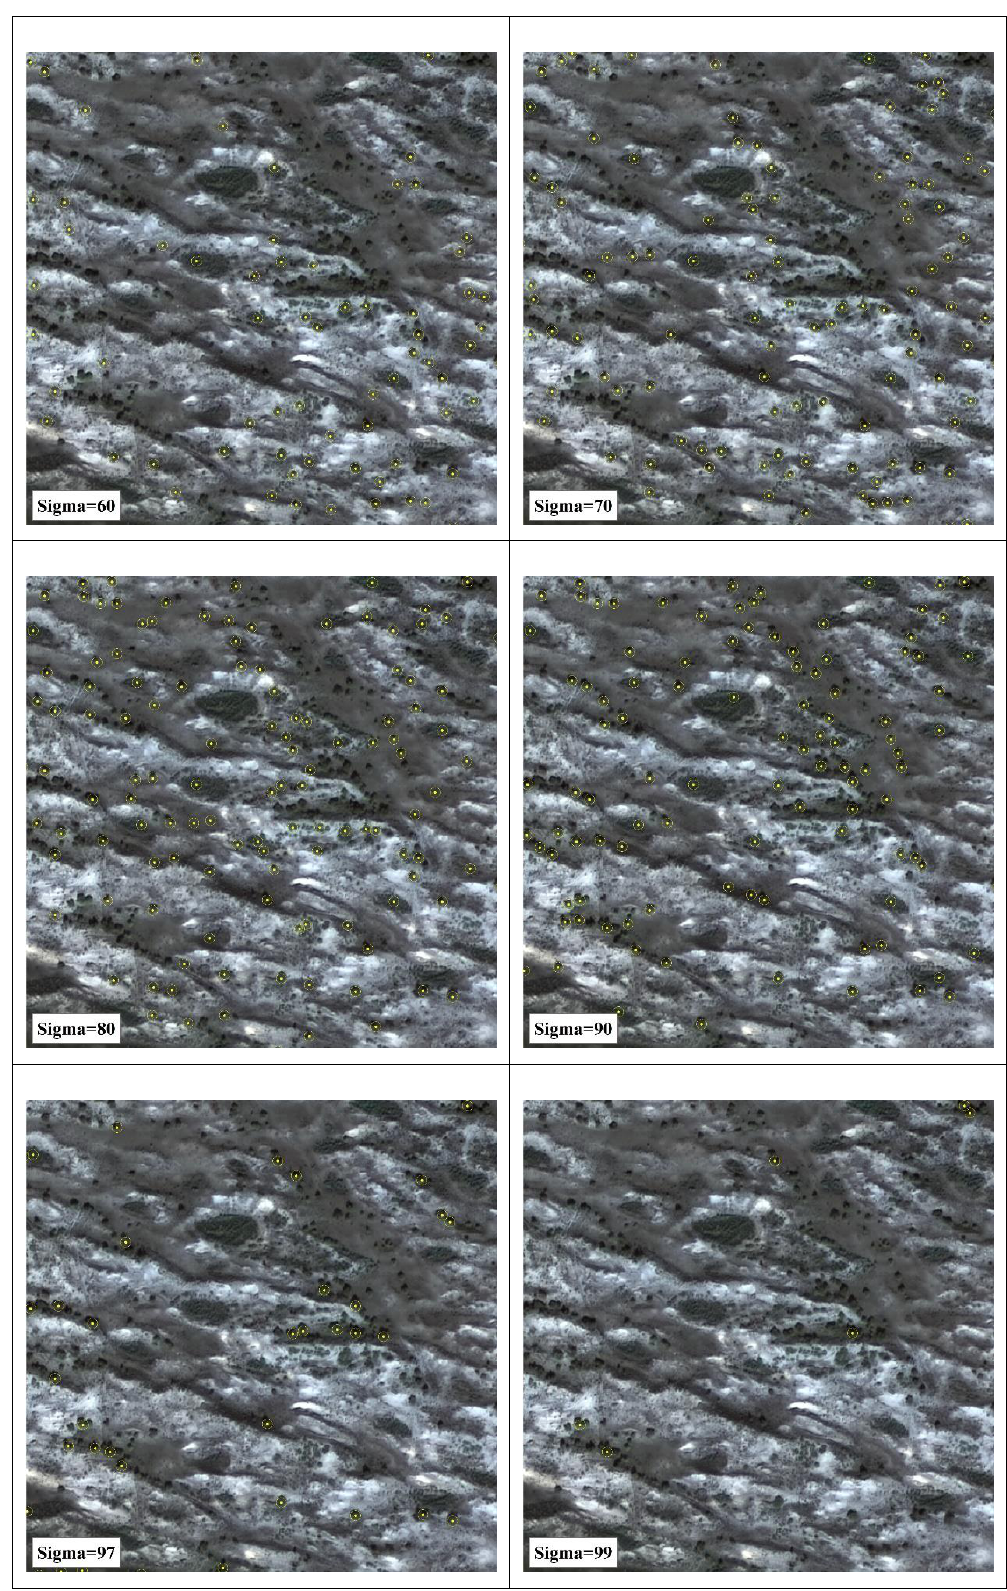
Figure 6. Extraction at different Sigma values (partial).